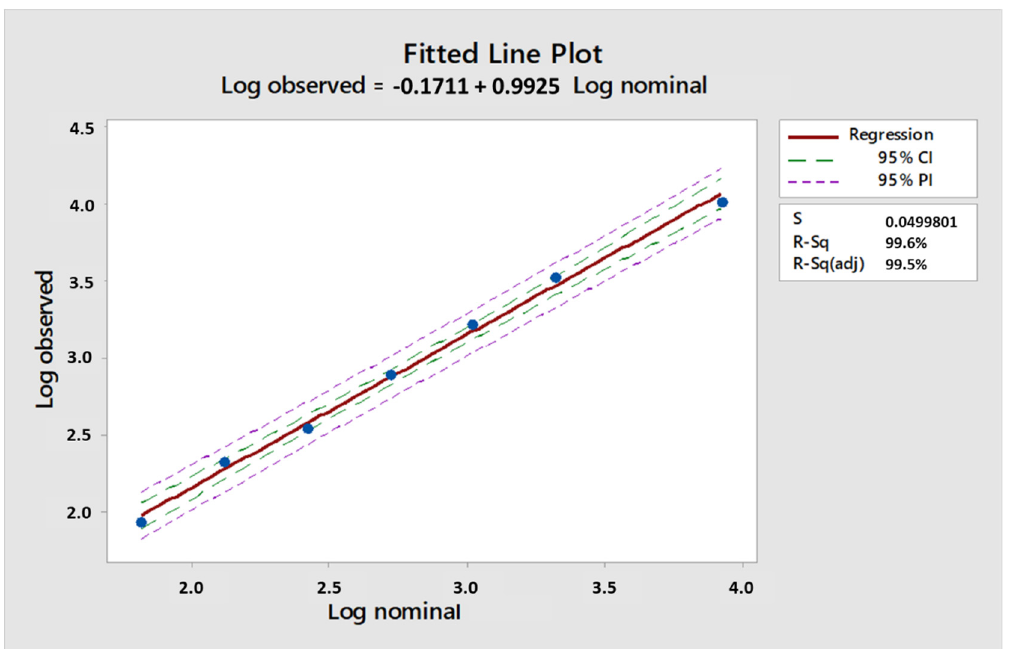
Figure 2. LogIC50 vs. log of serum dilution of samples tested to assess linearity both for the two Salmonella strains, S. Typhimurium D23580 and S. Enteritidis CMCC4314. Blue dots represent LogIC50 obtained for a specific serum diluted by each operator. The red line represents the linear regression trendline, and 95% CI (confidence interval) and 95% PI (prediction interval) are also reported.